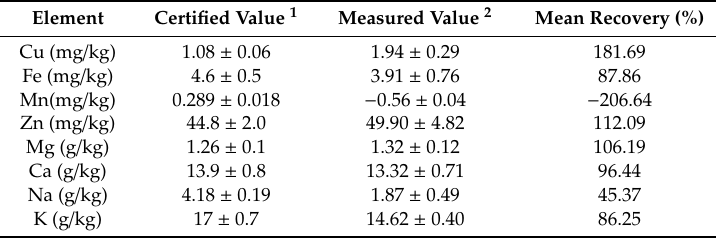
Table 2. Comparison of ICP-AES measured values and certified skim milk powder (ERM-BD 150). Element Certified Value